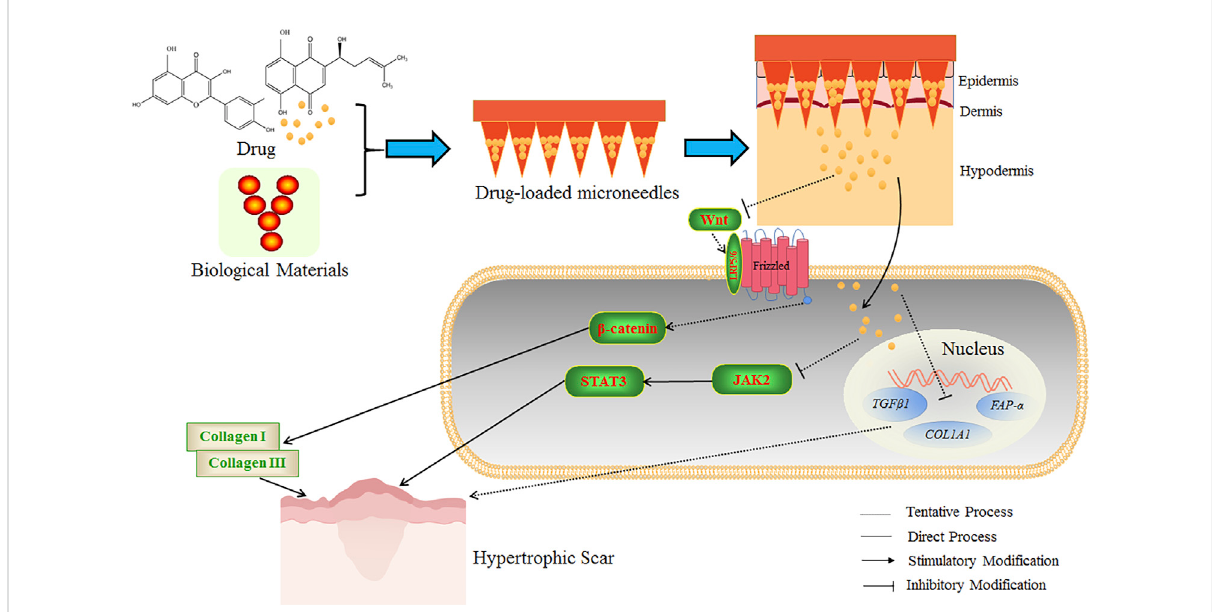
FIGURE 5 The schematic diagram of drug-loaded microneedles for the treatment of HS. Microneedles were prepared using biological materials and botanical drugs, which could establish many micro-dermal channels to accurately promote the penetration of drugs into the dermis and hypodermis. The Wnt ligand is a secreted glycoprotein that binds to Frizzled receptors, leading to the formation of a cell surface complex (Wnt- bound Frizzled combined with coreceptor LRP5/6), and β -catenin is subsequently activated and stabilized. The activated β -catenin can stimulate the transcription of Wnt target genes and the expression of fi brosis-related genes and promote the formation of collagen Ⅰ and Ⅲ to increase the HS formation. JAK2/STAT3 signaling pathway is essential in inhibiting apoptosis and tissue fi brosis. STAT3 is highly expressed in HS tissues. The application of Shikonin soluble hyaluronic acid microneedle could enhance the therapeutic effect of HS by down-regulating fi brosis- related genes to reduce the viability and proliferation of fi broblasts. The quercetin-loaded microneedle complex could improve the therapeutic effect on HS potentially by inhibiting the Wnt/ β -catenin signaling pathway, reducing STAT3 expression, and inhibiting the JAK2/STAT3 signaling pathway. The above microneedles could improve the anti-HS ef fi cacy of the botanical